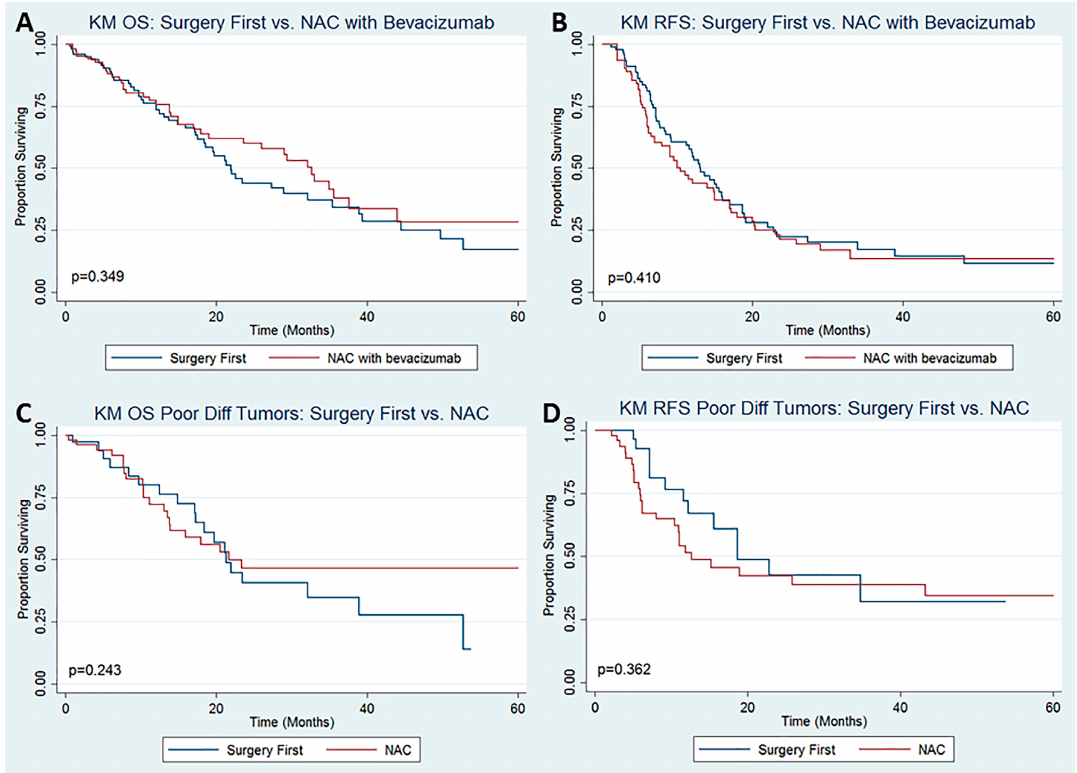
Figure 2. Kaplan–Meier Survival Analysis for ( A ) Overall Survival and ( B ) Recurrence-Free Survival among patients with CR-PM undergoing CRS ± HIPEC comparing patients who underwent NAC with bevacizumab versus those who did not undergo NAC and Kaplan-Meier Survival Analysis for ( C ) Overall Survival and ( D ) Recurrence-Free Survival among patients with CR-PM undergoing CRS ± HIPEC with poorly differentiated tumors ± signet ring histology comparing patients who underwent NAC versus those who underwent surgery first.